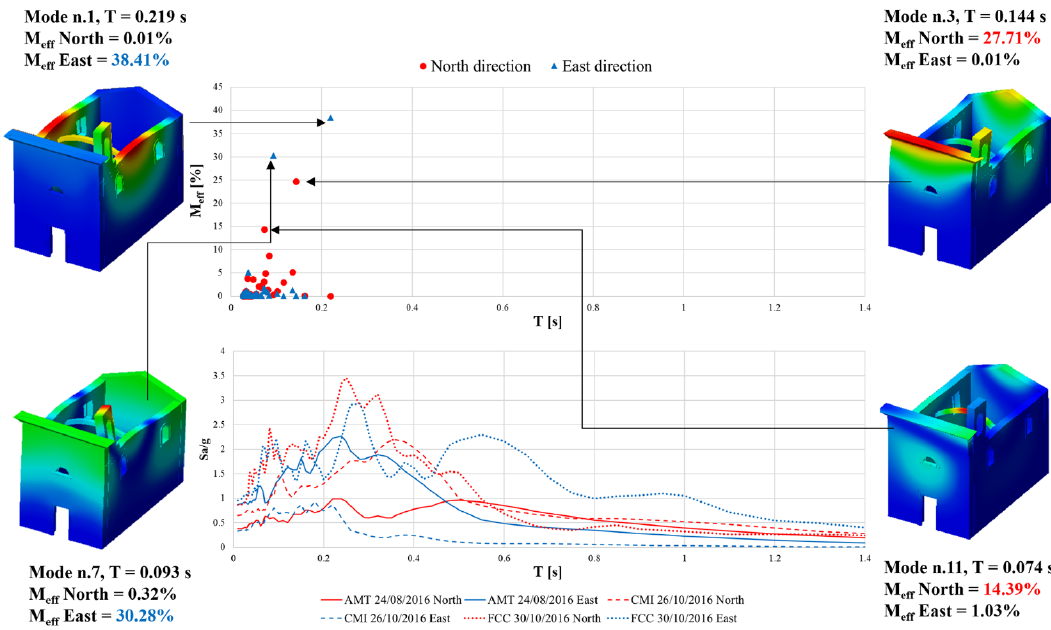
Figure 10. Distribution of modal shapes in the longitudinal and transversal directions and comparison with the pseudo- acceleration response spectra of the three main shocks of Central Italy seismic sequence of 2016 for Santissimo Crocifisso church in Arquata del Tronto (Ascoli Piceno, Central Italy).